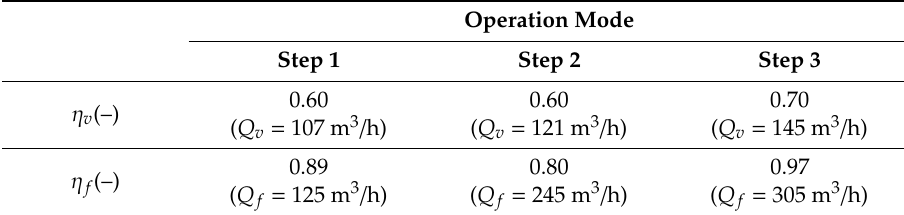
Table 4. Results of parameters η v and η f according to the flow